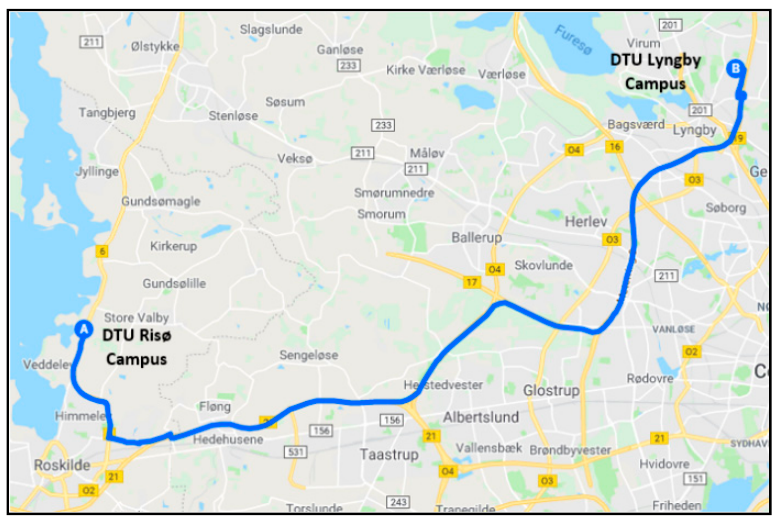
Figure 3. Location of the two Danish Technical University (DTU) campuses.